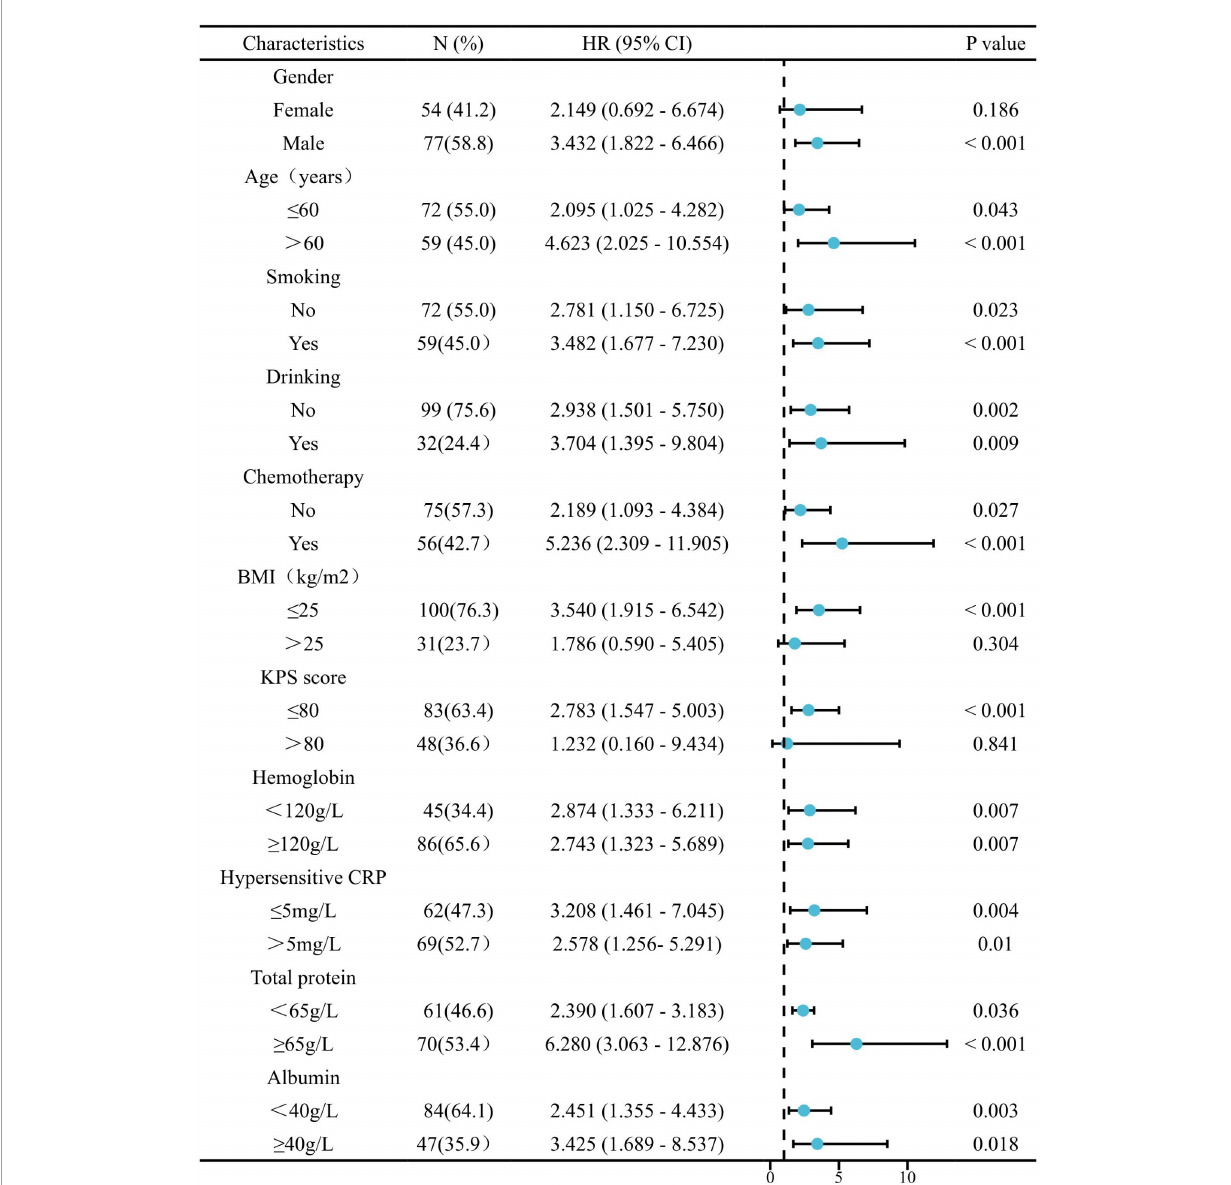
FIGURE3 The association between sarcopenia and hazard ratios of OS in various subgroups. BMI, body mass index; KPS, Karnofsky performance status; hCRP, hypersensitive C-reactive protein.